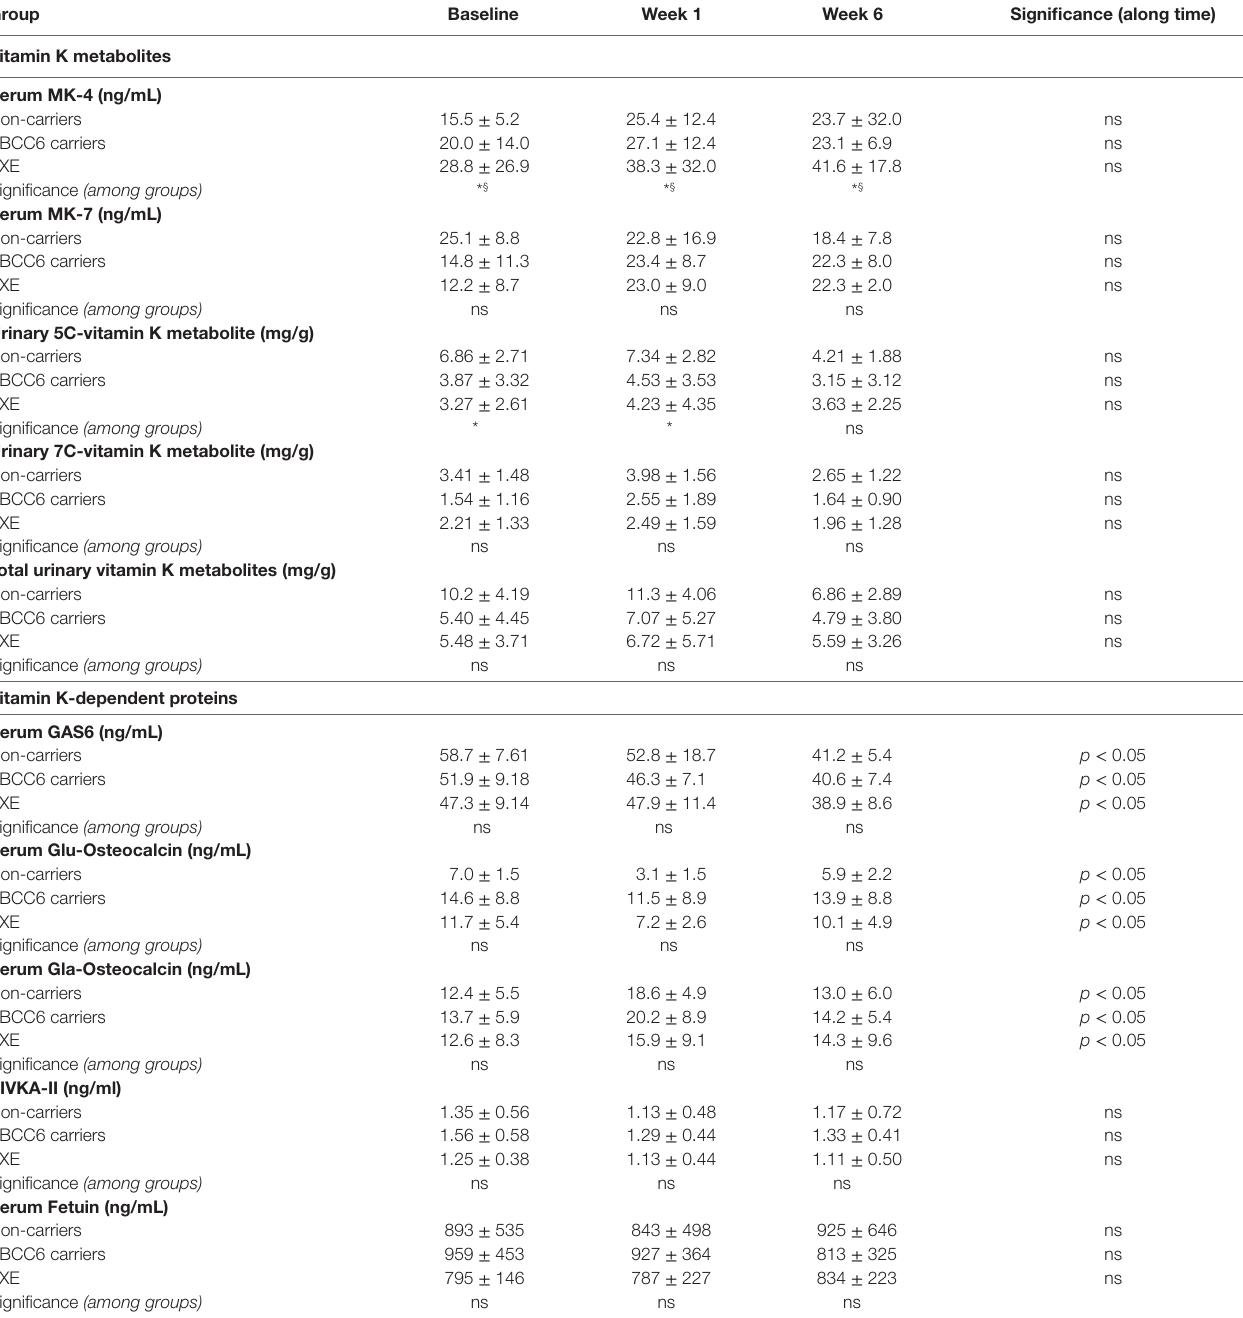
Table 4 | Vitamin K metabolites and dependent proteins at baseline and at 1 and 6 weeks post-phytomenadione administration in pseudoxanthoma elasticum (PXE) patients, in non-carriers and in ABCC6